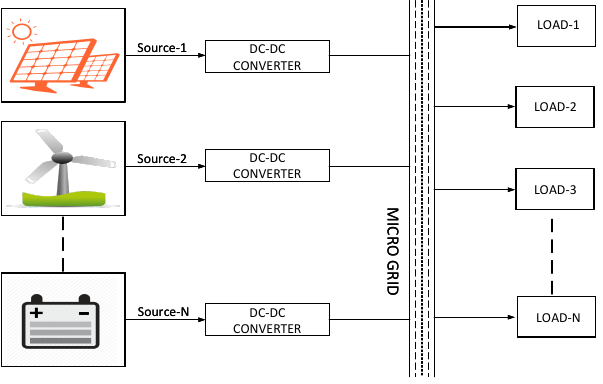
Figure 1. Connection of distributed energy resources to a Direct Current (DC)